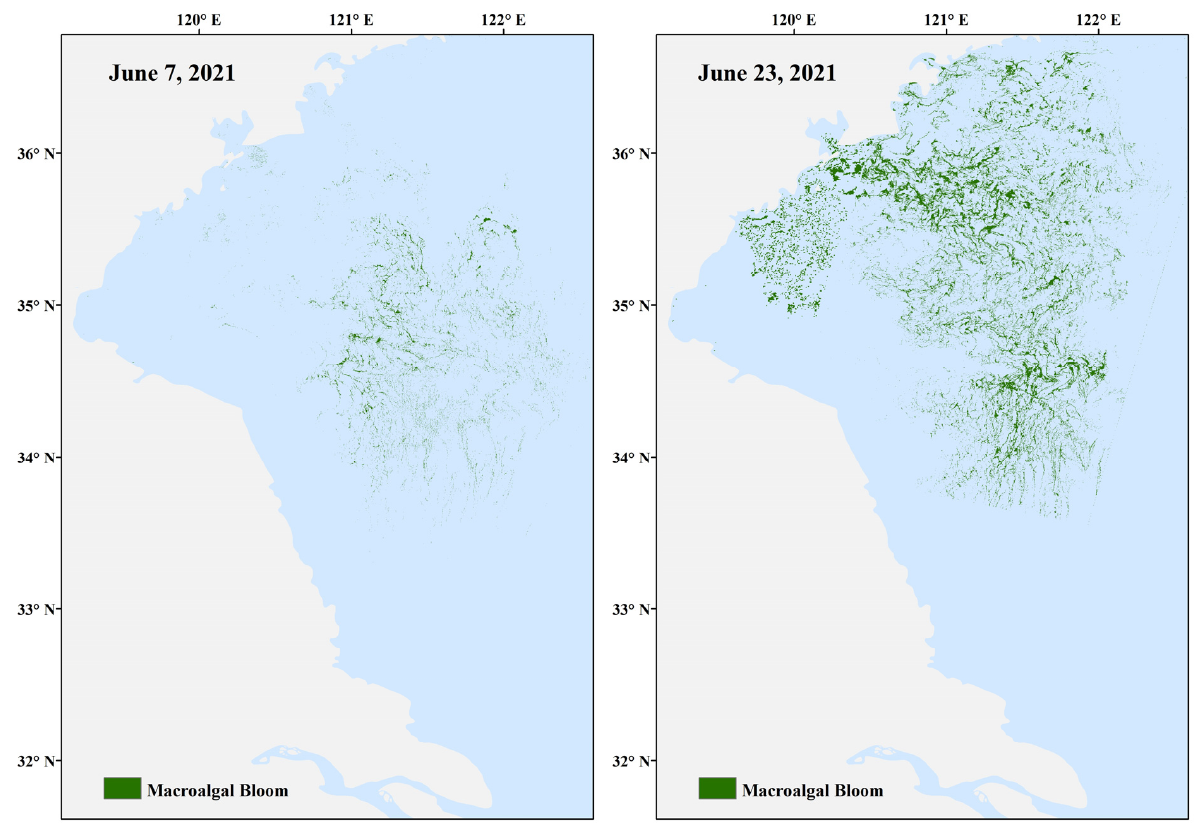
Figure 6. Distribution of macroalgal blooms in the Yellow Sea, China, derived from remote-sensing data in 2021 for 18 May, 28 May, 7 June, and 23 June (adapted from [57]).